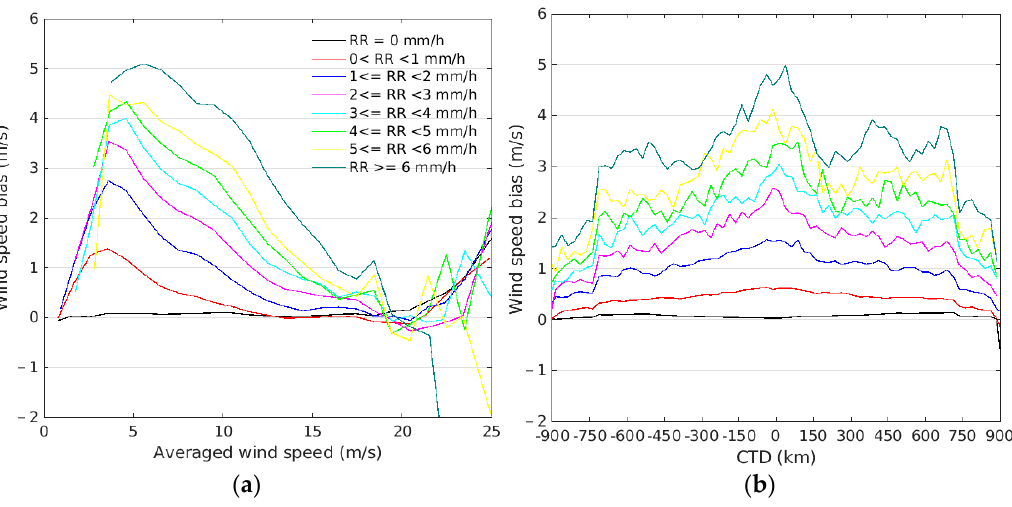
Figure 3. Bias of HSCAT-B wind speed (w.r.t. ECMWF winds) as a function of ( a ) the averaged HSCAT-B and ECMWF wind speed and ( b ) the cross-track distance to the sub-satellite track. Curves in different colors indicate different rain rates, as shown in the legend.